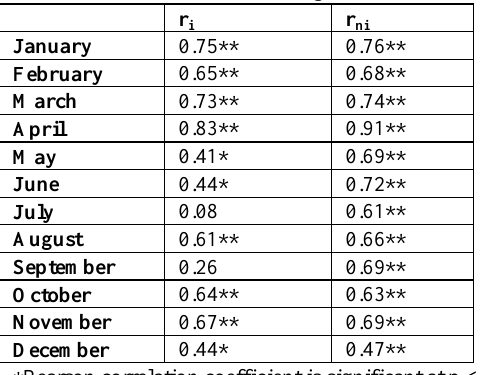
Table 1. Correlation coefficient between AQI and individual messages.